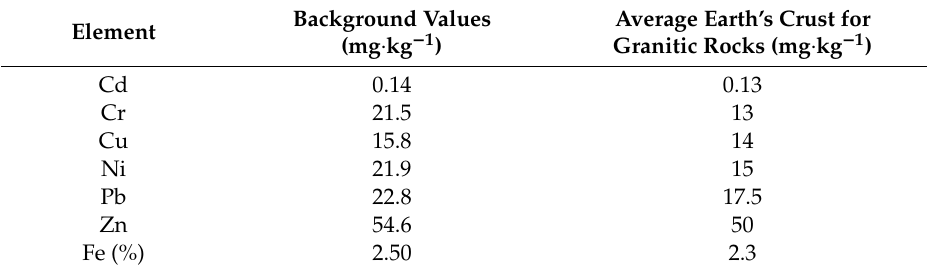
Table 2. Mean metal concentrations (background values) in soils according to Salminen et al. [37] and average Earth’s crust according to Turekian and Wedepohl